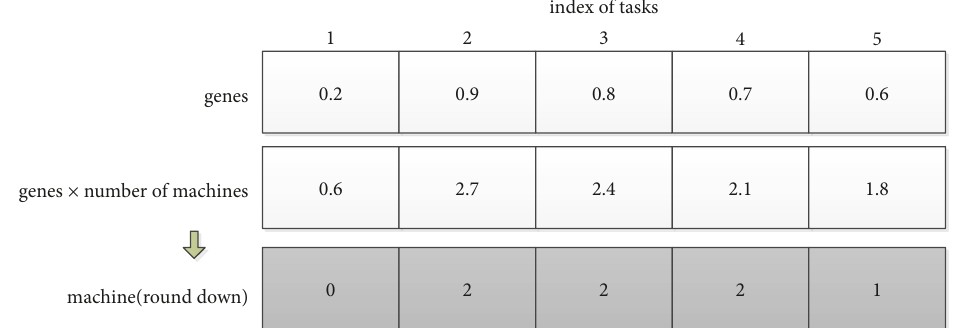
Figure 4: The encoding and decoding method.